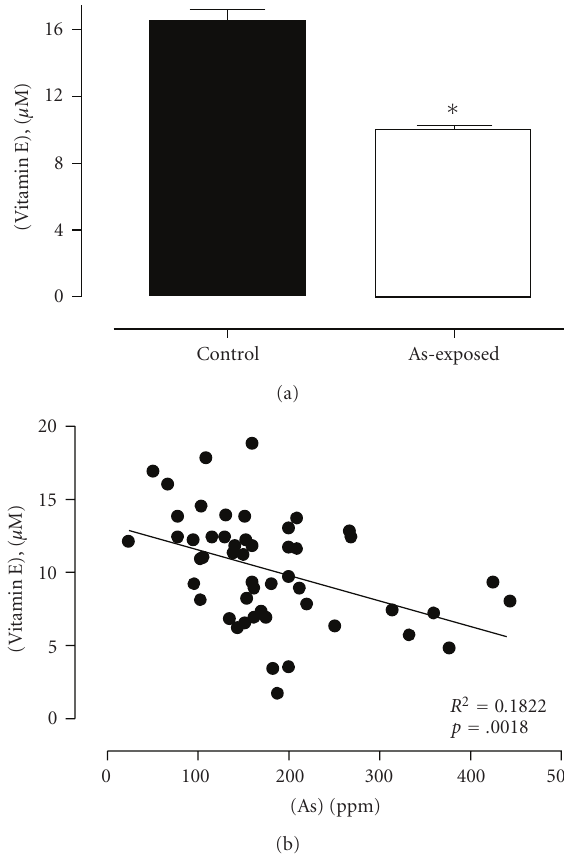
Figure 3: Comparative levels of vitamin E in plasma samples from low- and high-exposure human populations and correlation between plasma vitamin E concentration and urinary excretion of As fromhighly As-exposed population. (a)VitaminE concentration profile in the plasma of the low-As-exposure group ( n = 31) and the high-As-exposure group ( n = 50). The statistical analysis indicates significant di ff erences between the two groups (U-Mann- Whitney test P < . 0001). (b) Relationship between plasma vitamin E concentration ( μ M) and As concentration in urine (ppm) from the highly exposed population. The relationship between the two variables was determined by R -Pearson ( P < .